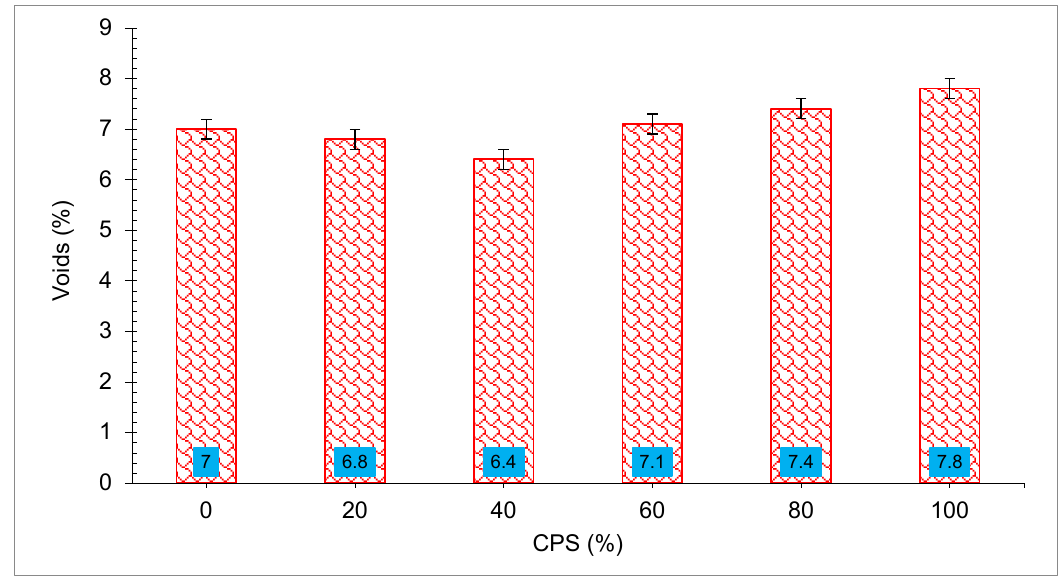
Figure 16. Voids in concrete: data source [33].